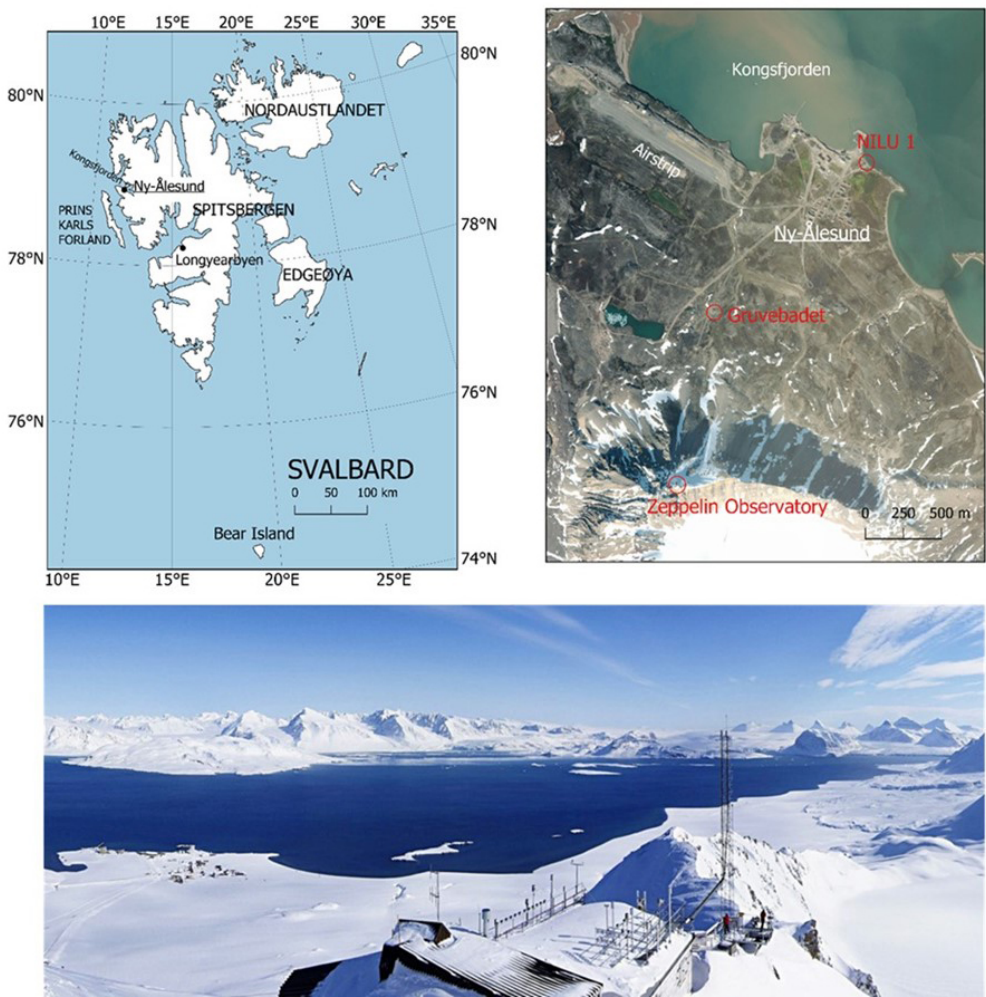
Figure 2. Top left: map of the Svalbard archipelago. Top right: satellite image of Ny-Ålesund with the measurement sites at NILU-1, Gruvebadet, and the Zeppelin Observatory in red. Bottom: view of the Zeppelin Observatory looking down over the Ny-Ålesund settlement and Kongsfjorden. Top left, map data: Svalbard Kartdata; scale: 1 : 1000000; credit: Norwegian Polar Institute, https://doi.org/10.21334/ npolar.2014.63730e2e (last access: 18 June 2021). Top right, map data: Esri satellite; scale: variable resolution; credit: Esri, Maxar, Earthstar Geographics, USDA FSA, USGS, AeroGRID, IGN, IGP, and the GIS User Community, https://server.arcgisonline.com/ArcGIS/rest/services/ World_Imagery/MapServer (last access: 18 June 2021). Top panels produced using the QGIS geographic information system, Open Source Geospatial Foundation project, http://qgis.osgeo.org (last access: 18 June 2021). Bottom, photo credit: Ove Hermansen,